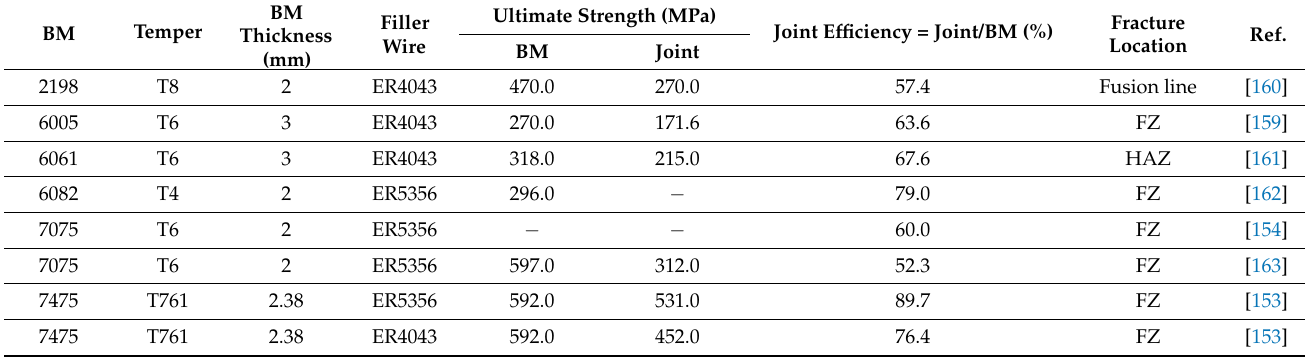
Table 8. Summary of the tensile properties of age-hardening aluminum alloy butt joint welded by conventional CMT welding.